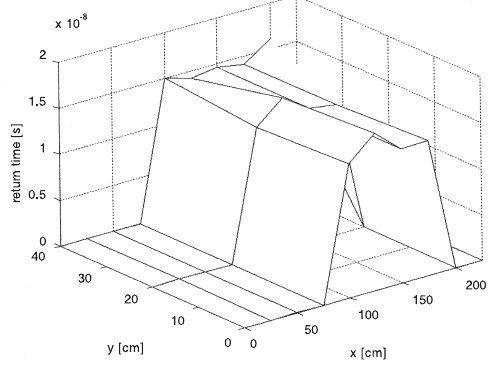
Fig. 8. Planar scans of the return times of the mean- ingful radar pulses for the metal sheet of fi g. 3.